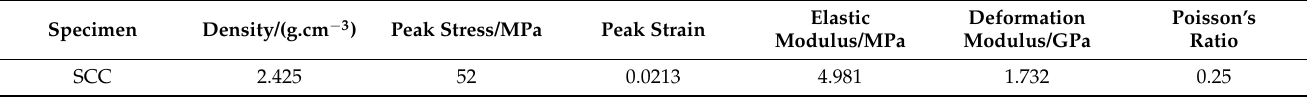
Table 4. Basic physical and mechanical properties of